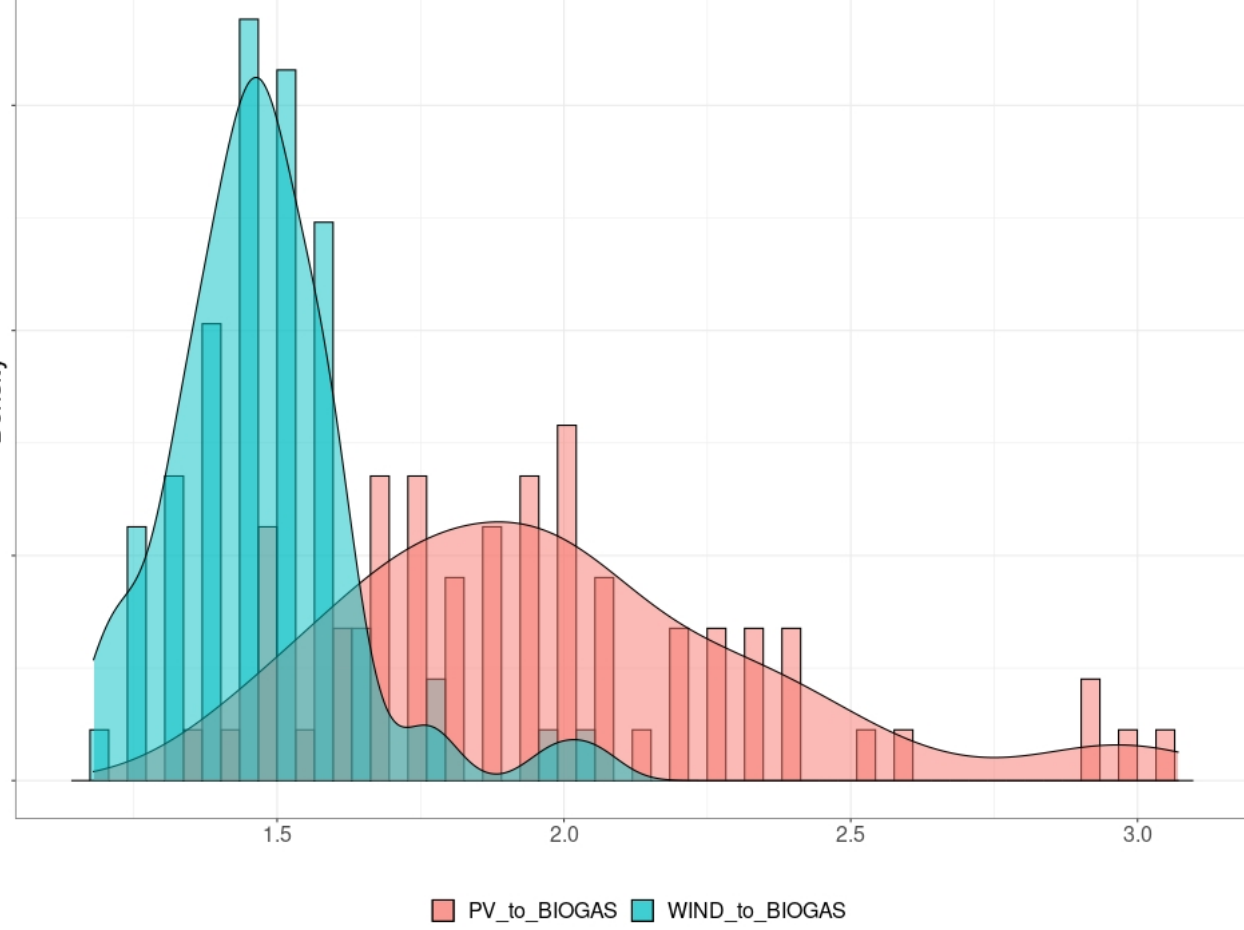
Figure 4. Distributions of relative filling of network deposits taking account of generation tech- nologies.